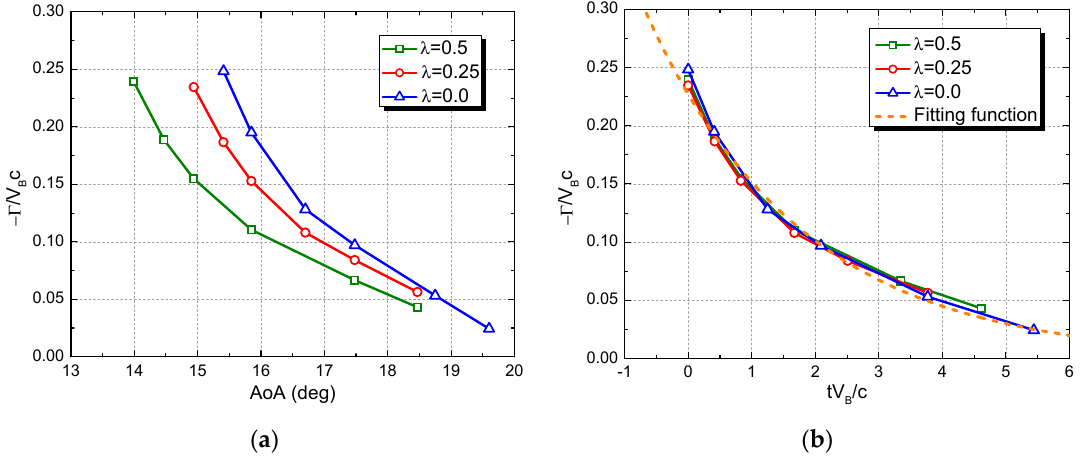
Figure 20. Comparisons of LEV dissipation between different oscillating velocities. ( a ) Variation with AoA. ( b ) Variation with time.